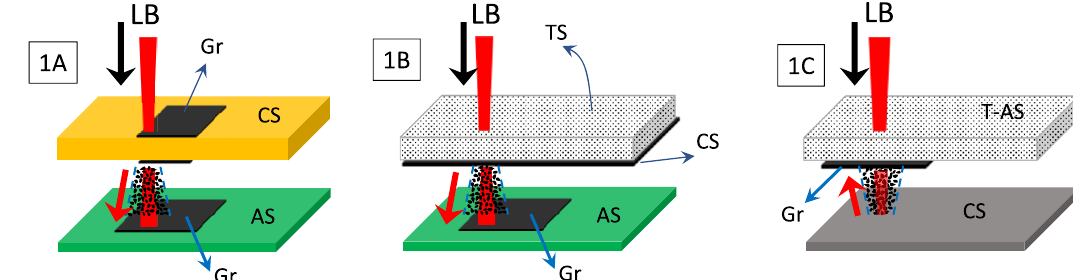
Fig. 1 Irradiation geometries. Variants of forward and backward LEST graphene synthesis and deposition onto a